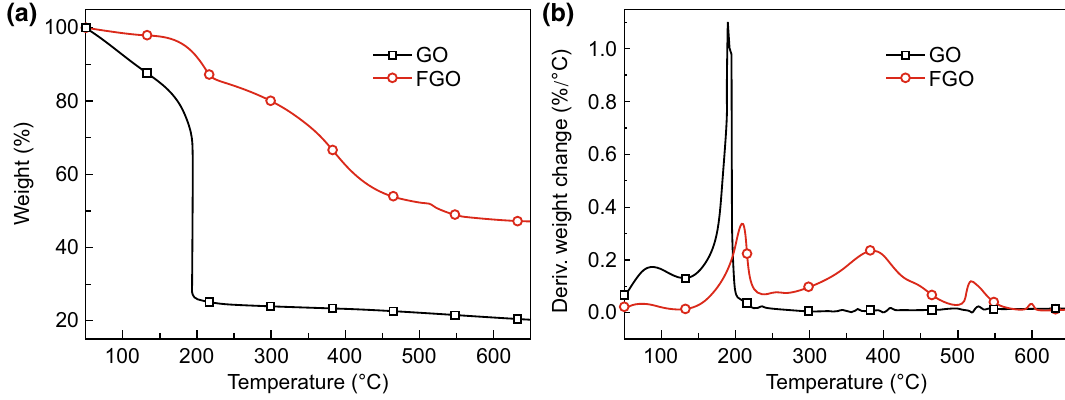
Fig. 3 TGA profiles of GO and FGO under nitrogen